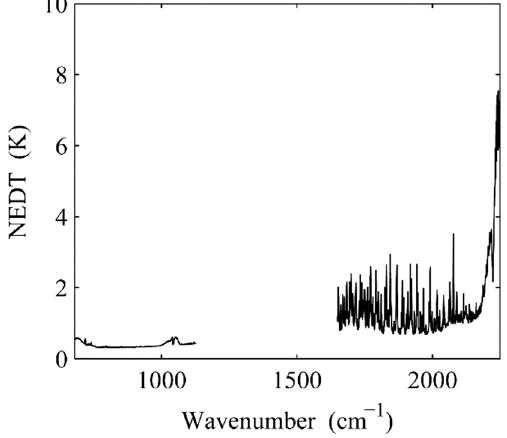
Figure 1. The observation error of GIIRS.